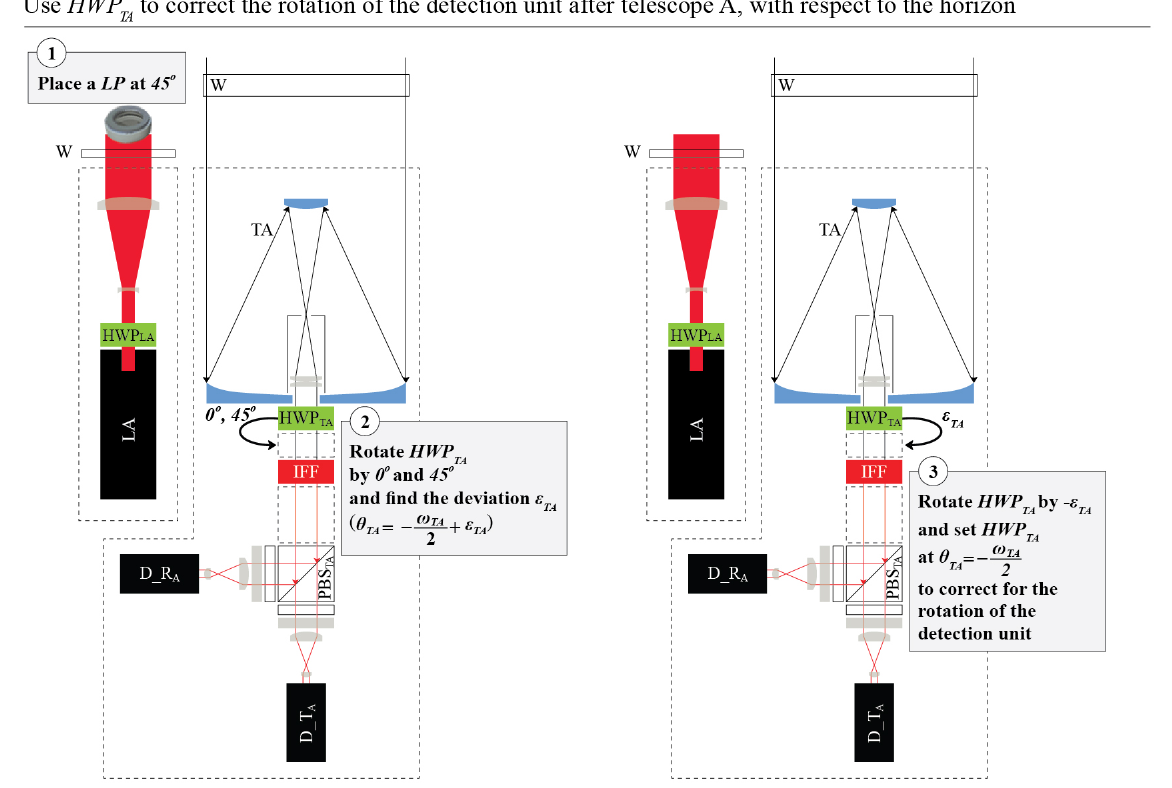
Figure 10. Methodology for correcting the measurements I i _TA_ s due to the rotation of the detection unit after telescope